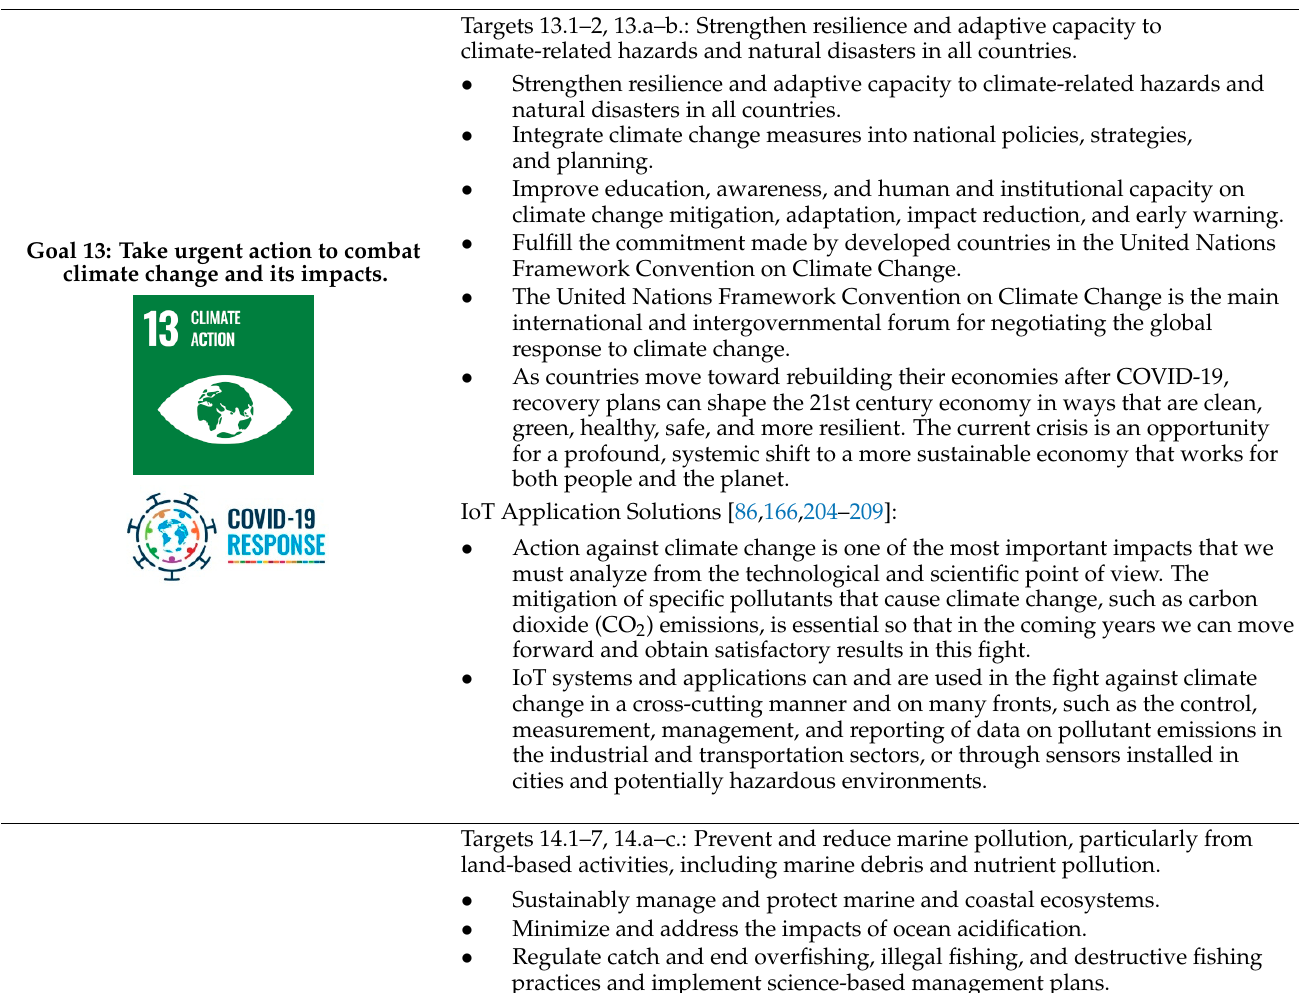
Table 5. Impact of the Sustainable Development Goals on IoT applications for improving health and the environment. SDGs Targets Goals and Application to IoT Systems